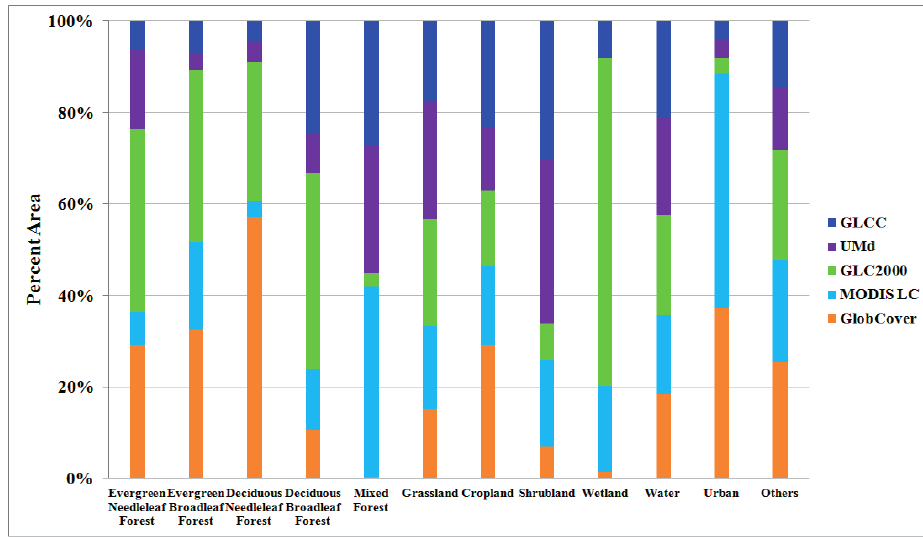
Figure 2. The percent area comparison of the five global land cover data sets regarding target classes over